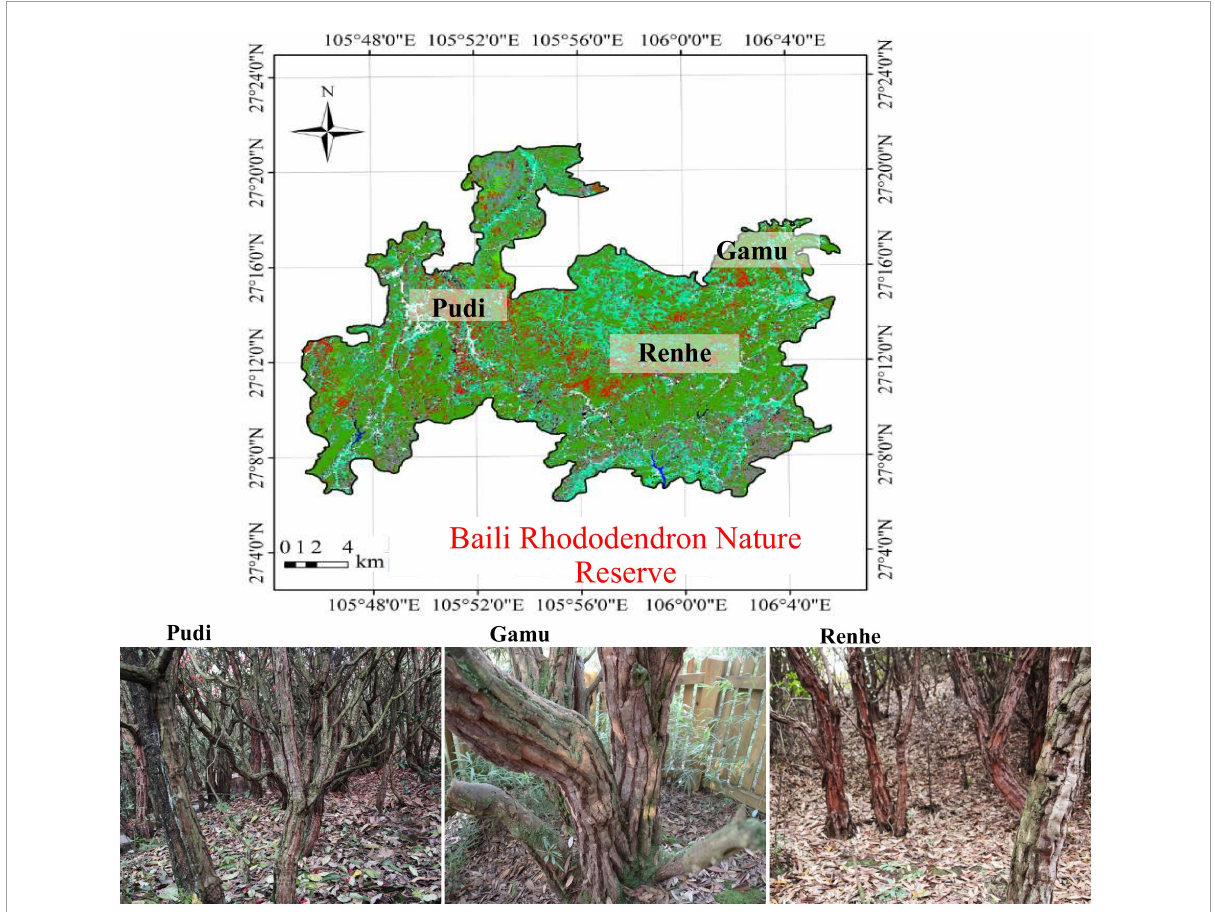
FIGURE1 Study site distribution and three Rhododendron delavayi forest understory